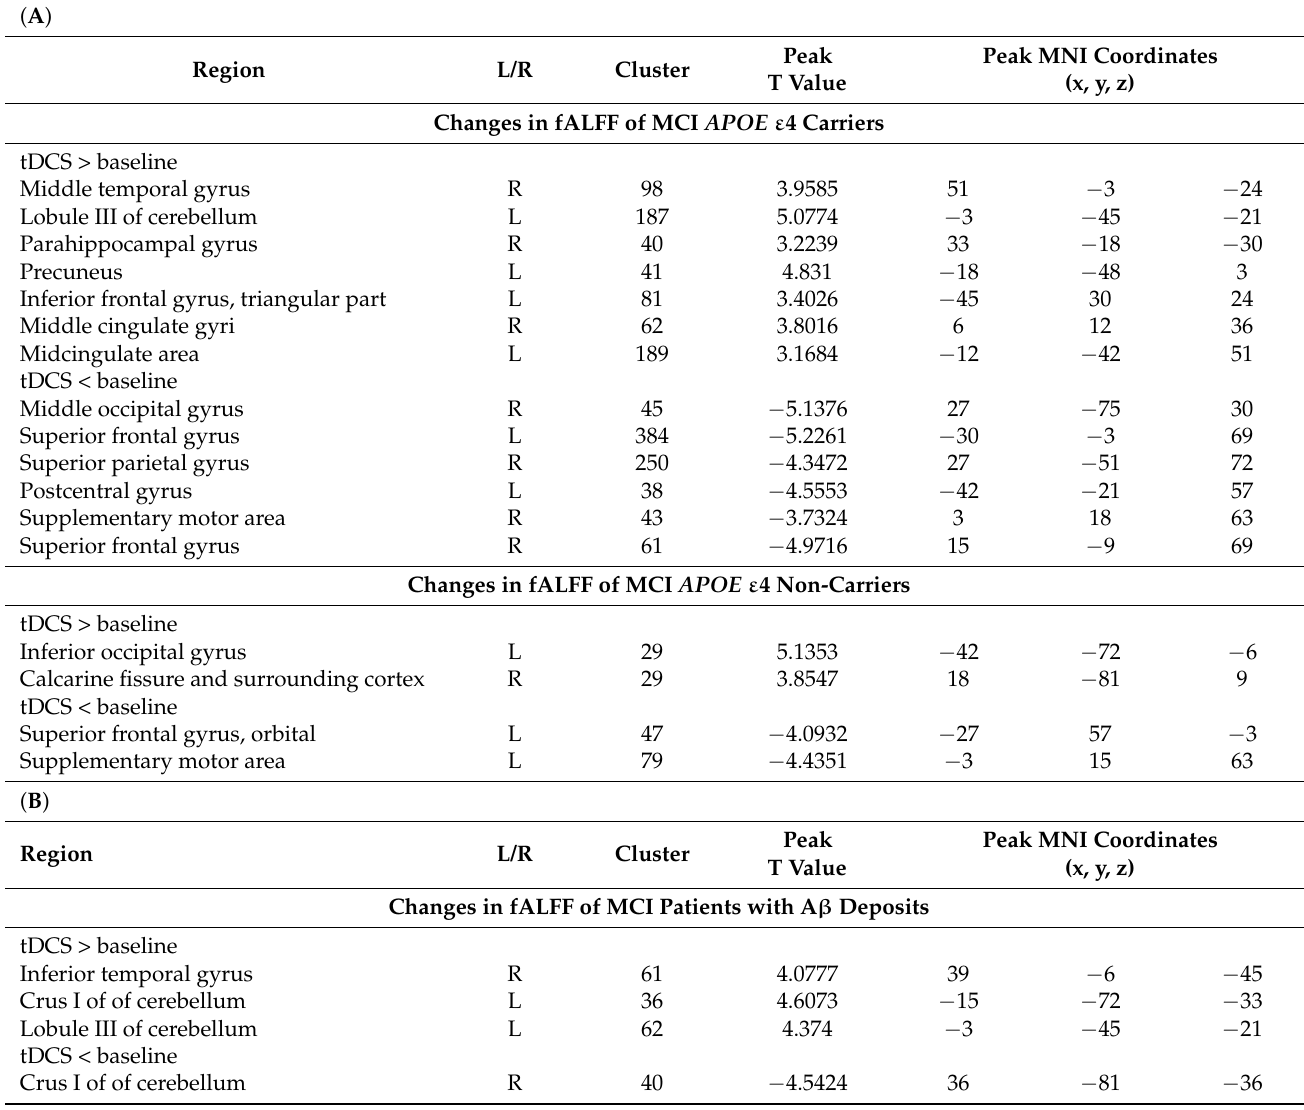
Figure 3. Significant changes in DC after tDCS of mild cognitive impairment patients ( A ) with and without the APOE ε 4 allele, and ( B ) with and without A β deposits. Whole-brain voxel-wise fALFF analysis results. Whole-brain voxel-wise DC analysis results. Thresholds were set using GRF correction at a p-value of <0.05, voxel p < 0.001. The statistical threshold of the cluster size is described in Figure 3. Abbreviations: MNI, Montreal Neurological Institute coordinate; aMCI, amnestic mild cognitive impairment group; L/R, left/right; tDCS, transcranial direct current stimulation; fALFF, fractional amplitude of low-frequency fluctuation. Table 2. Changes in fALFF of MCI patients after tDCS, according to ( A ) APOE genotype and ( B ) A β deposits.